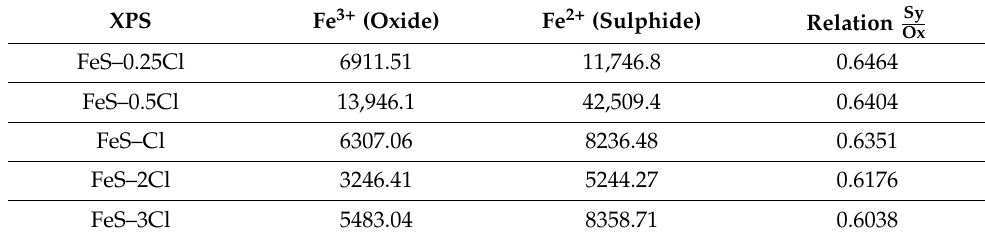
Table 6. Degradation results on visible-light region.